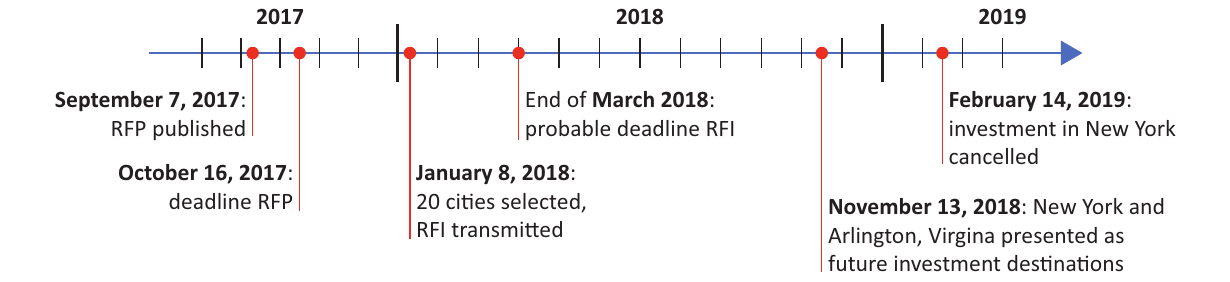
Figure 4. Timeline of the HQ2 decision process.